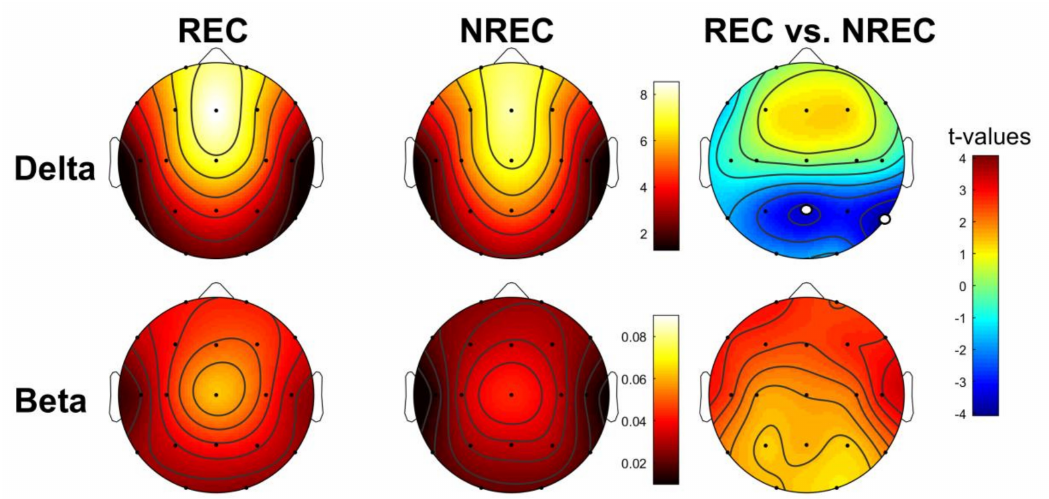
Figure 2. Topographic distribution of the total NREM sleep EEG power in the non-recall (NREC) and recall (REC) groups and statistical maps. The EEG activity for the delta (0.5–4.75 Hz) and beta (16–24.75 Hz) frequency bands is reported and expressed as the percentage of the total EEG power within the whole topography. The maps are scaled between the minimal and maximal power values for each frequency band, considering both the NREC (1st column) and REC (2nd column) group. Statistical maps of the comparisons (unpaired t -test) between the NREC and REC groups are also plotted (3rd column) both for the delta and beta bands. The statistical maps are scaled symmetrically according to the absolute maximal t -value across the statistical comparisons. Significant di ff erences after the Bonferroni correction for multiple comparisons are indicated by white dots ( p ≤